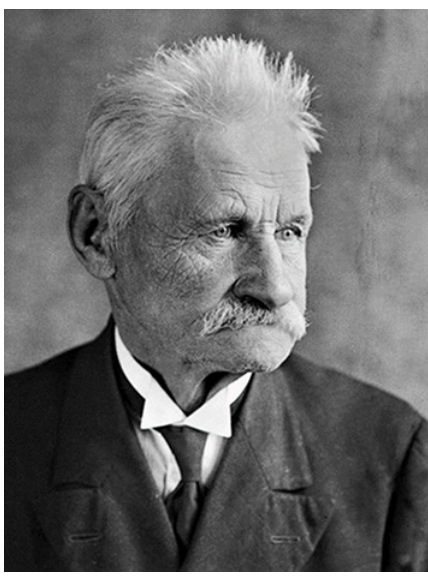
Figure 3 Portrait of professor Józef Paczoski, a pioneer of phytosociology (PWN,